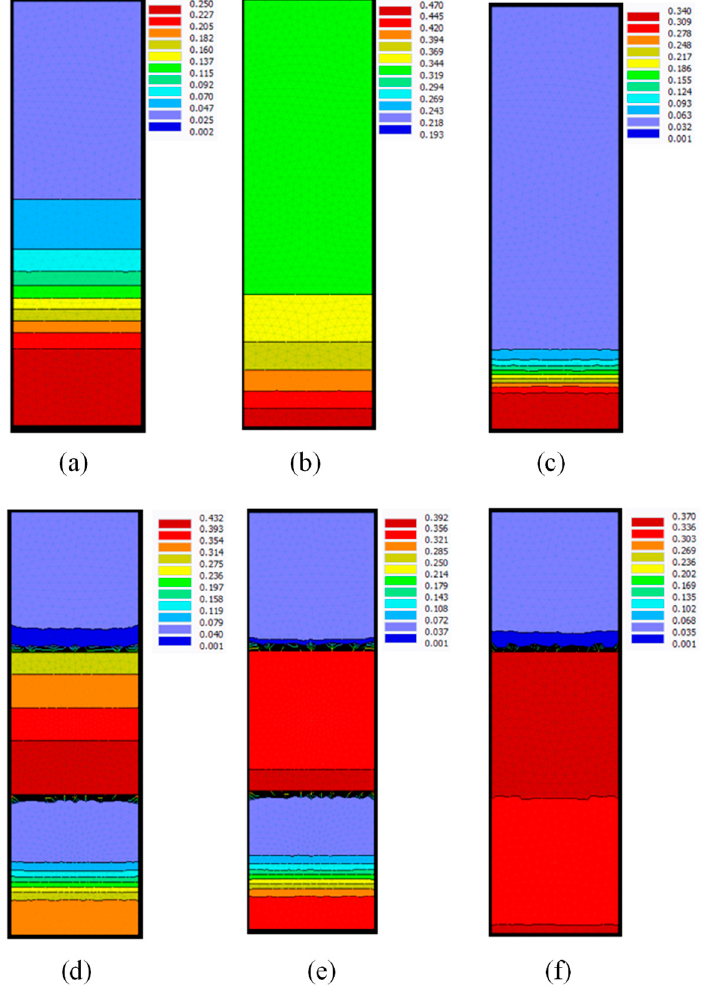
Figure 3. Calibrated Water Content HYDRUS Graphical Outputs ( a ) Sand, ( b ) Cedar Canyon, ( c ) Alluvial, ( d ) Dense Woodchips, ( e ) Loose Woodchips, and ( f ) Biochar.